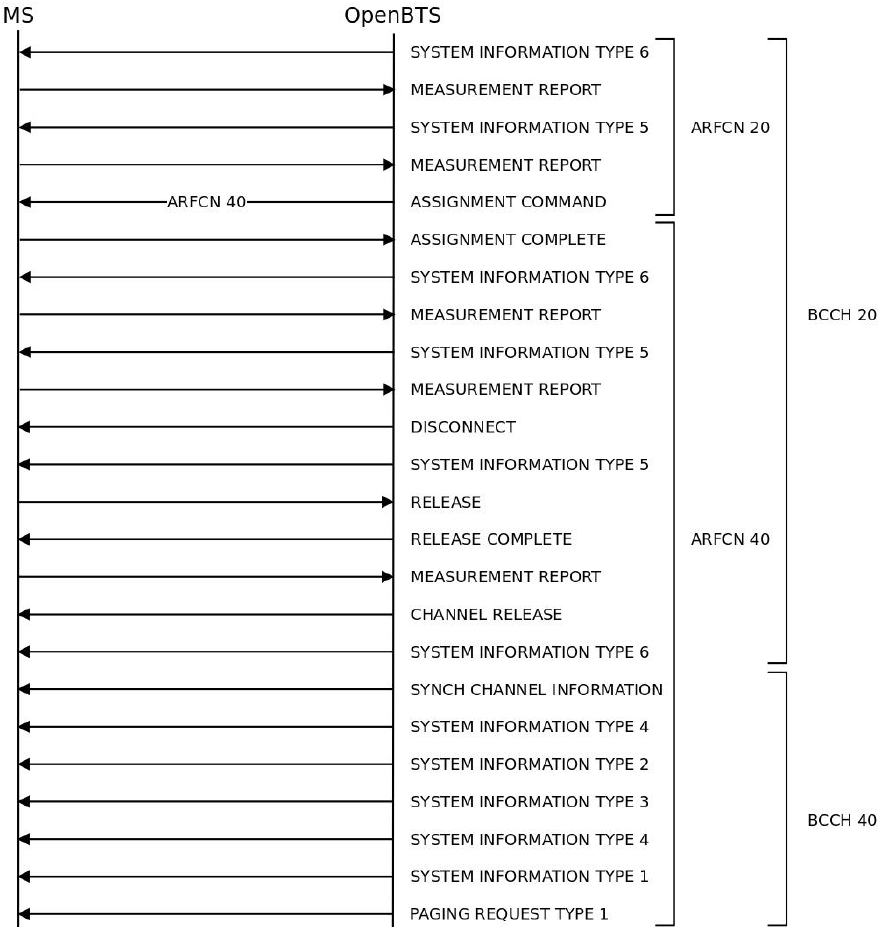
Figure 7. Layer 3 message exchange for channel change in dedicated